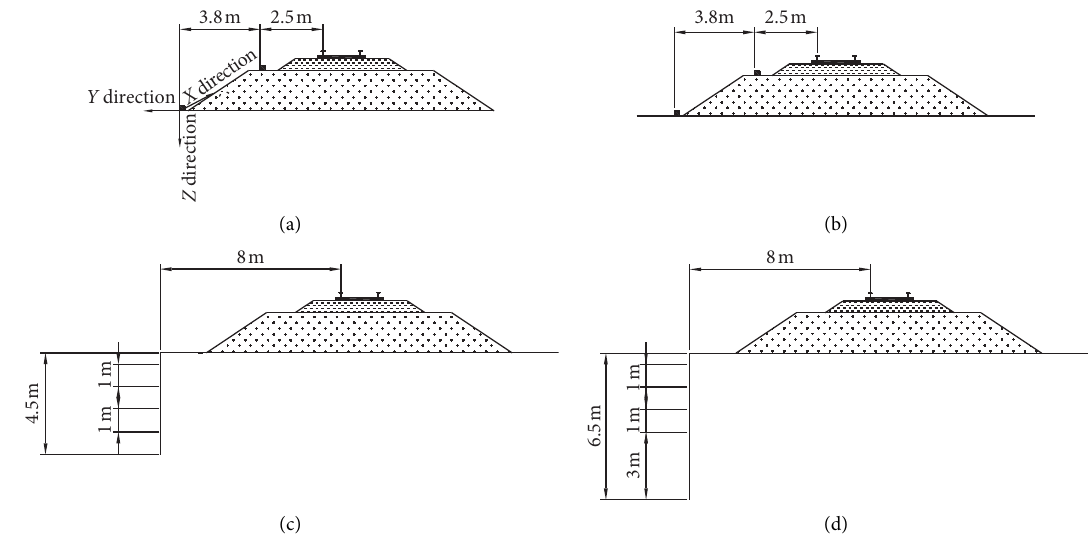
Figure 6: Schematic diagram of the layout of the vibrator pickup. (a) The layout direction of the vibrator. (b) Section K329+ 530. (c) Section K330+990. (d) Section K331